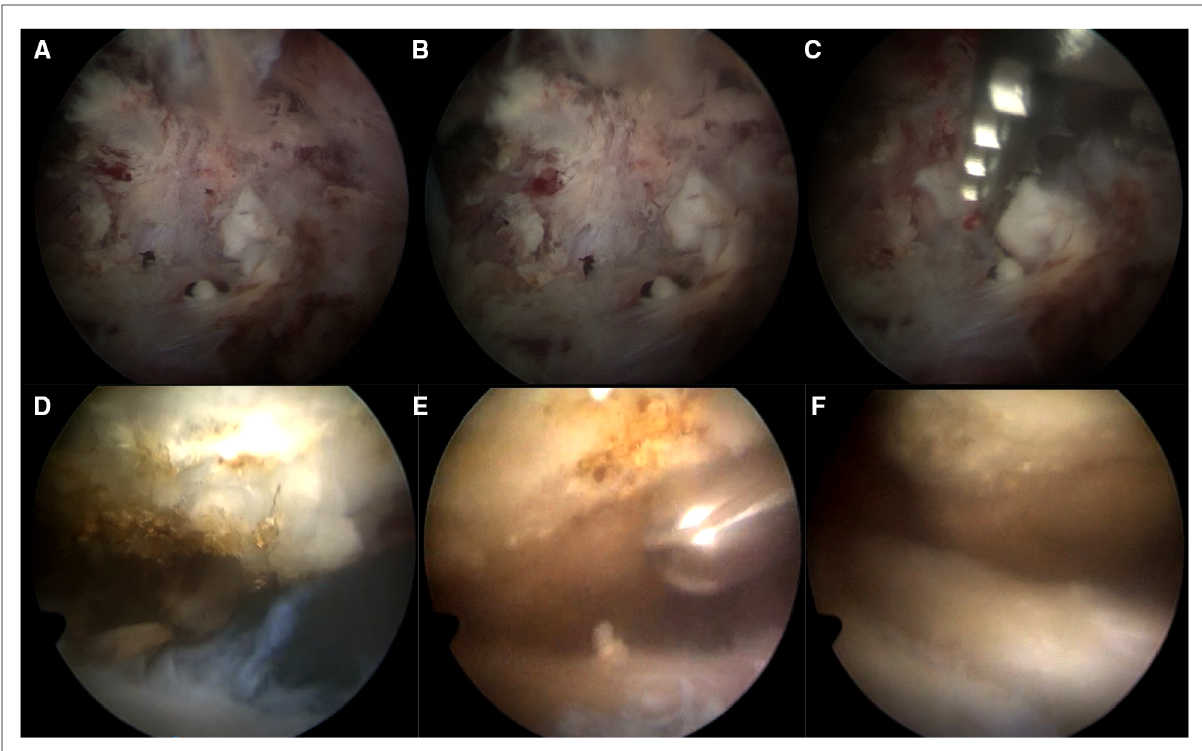
FIGURE 1 Intraoperative images: ( A ) Group A clean the synovium in the joint cavity, and toothpaste-like white calci fi cation spillage can be seen. ( B ) Group A stripped the calci fi ed surface capsule to promote the fl ow of toothpaste-like white calci fi cation. ( C ) Group A used soft tissue grippers and planers to debridement around calci fi cations. ( D ) Group B images before subacromial decompression. ( E ) Group B used a planer to debridement the acromion. ( F ) Picture of the surgical area after subacromial decompression in Group